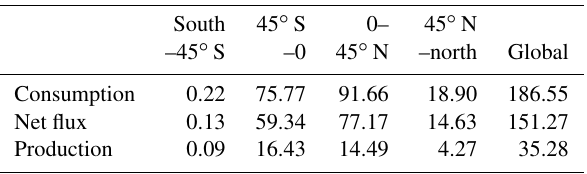
Table 3. Regional soil CO consumption, net flux and production (TgCOyr − 1 ) during 2000–2013.